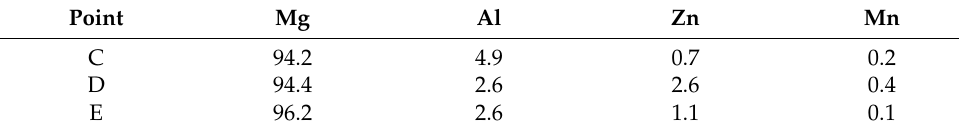
Table 5. EDS results taken from points C, D, and E in Figure 11 (at.%).